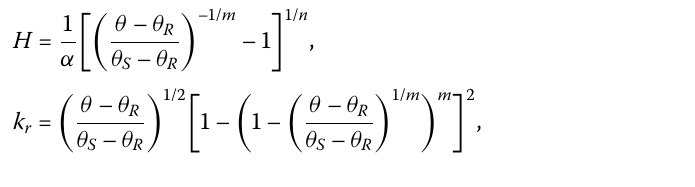
Table 2 The results of θ obtained from the present method and the FEM in x d = 9 mm t (min) Present